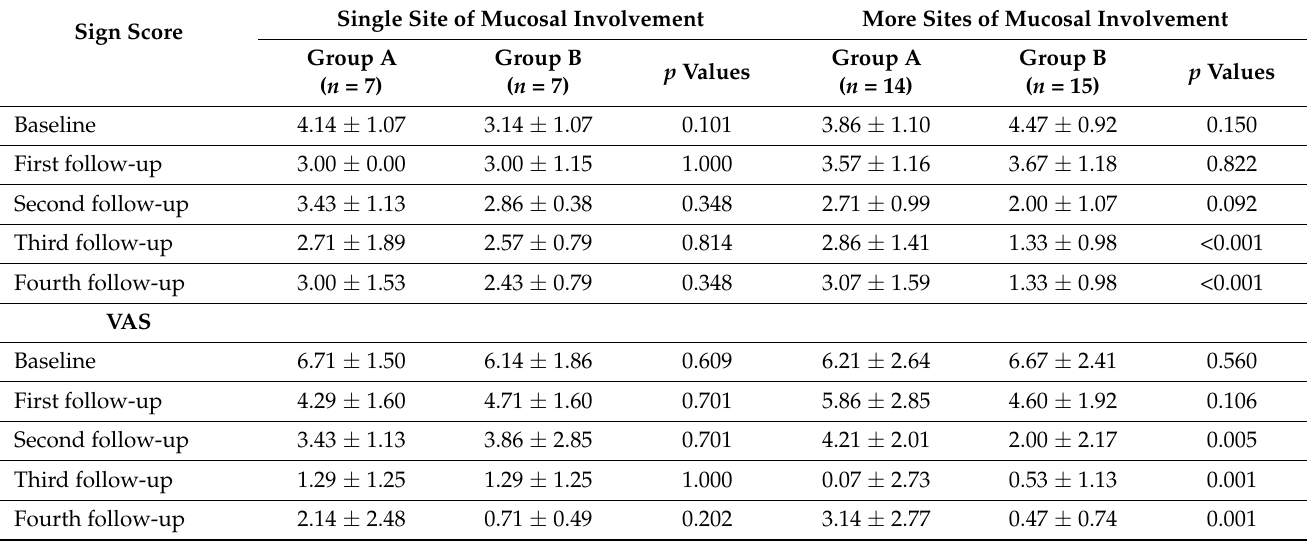
Table 4. Comparison of sign score and VAS between groups with different sites of mucosal involvement.